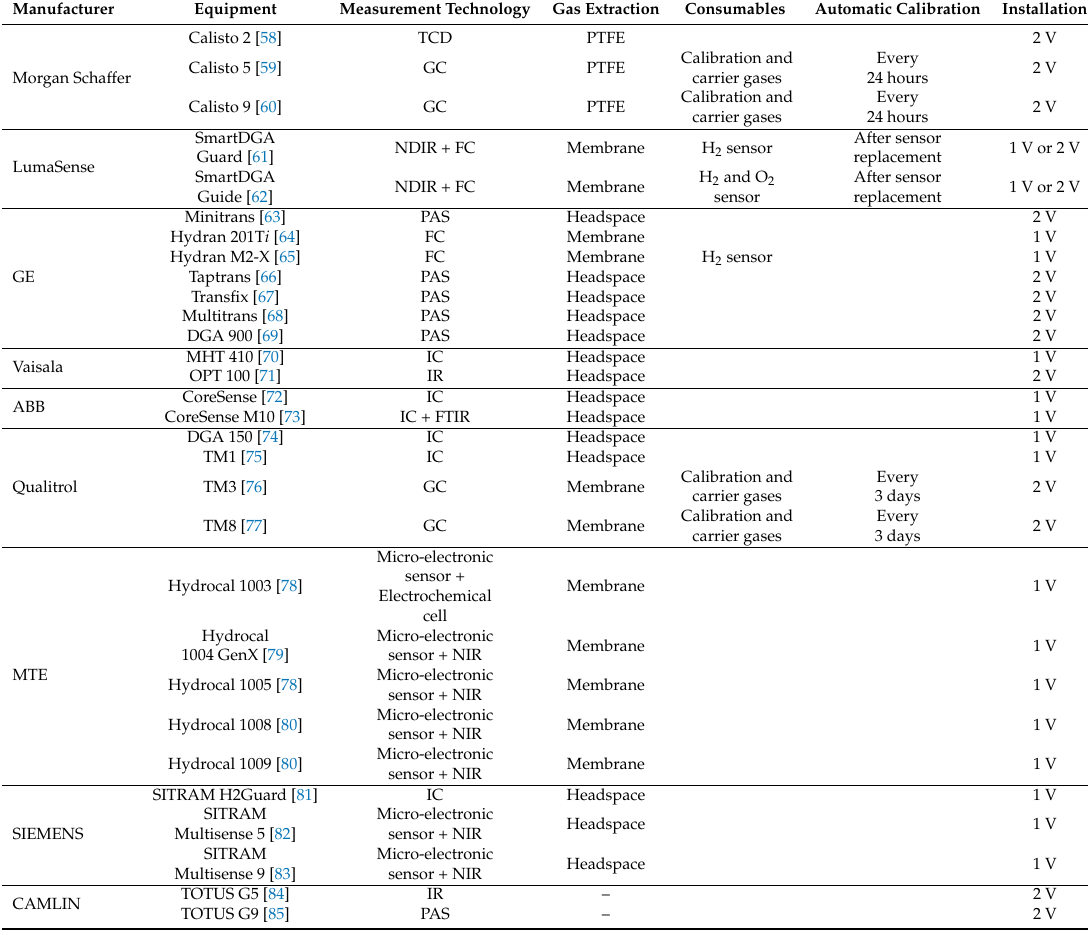
Table 4. List of manufacturers and gas-in-oil